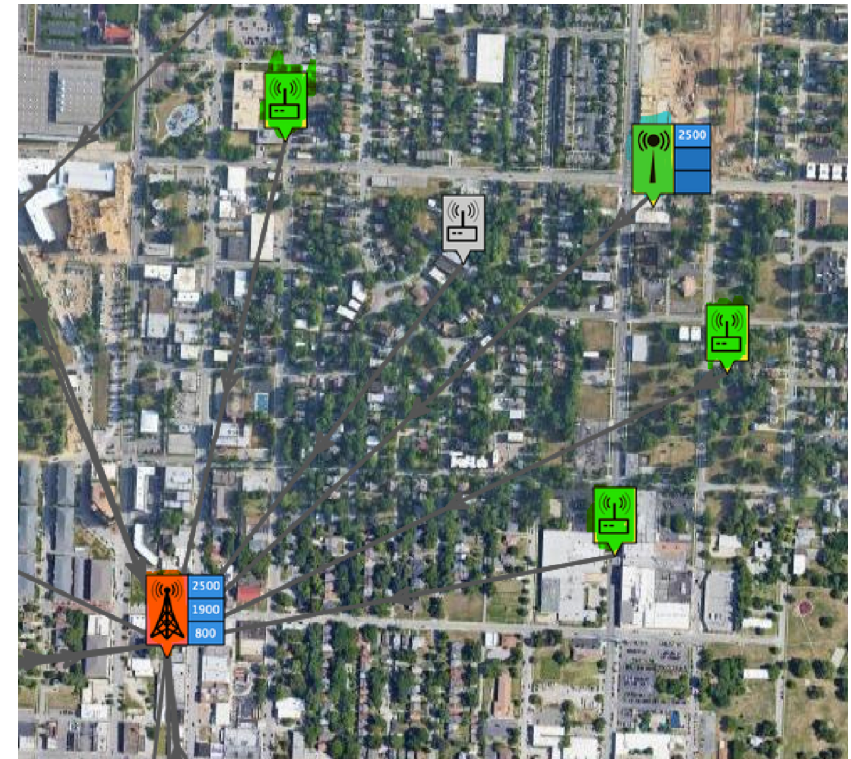
Figure 6. Example of real world relay